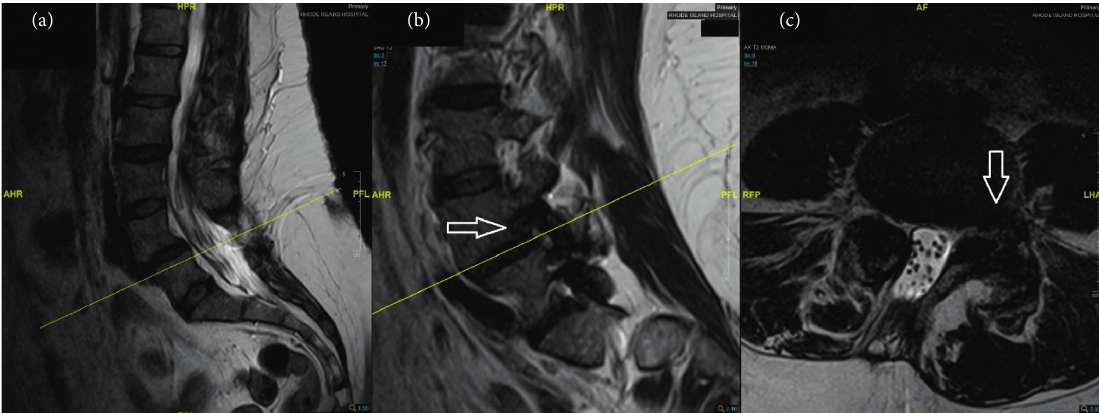
Figure 1: Preoperative lumbar MRI. (a) Midline sagittal T2-weighted MRI demonstrates the L4-5 spondylolisthesis and the prolapsed thecal sac. (b) Left of midline sagittal T2-weighted MRI with foraminal view demonstrates the left L4-5 (arrow) foraminal compression of the exiting L4 nerve. (c) Axial T2-weighted MRI demonstrates left L4-5 far lateral disc herniation compressing the exiting L4 nerve